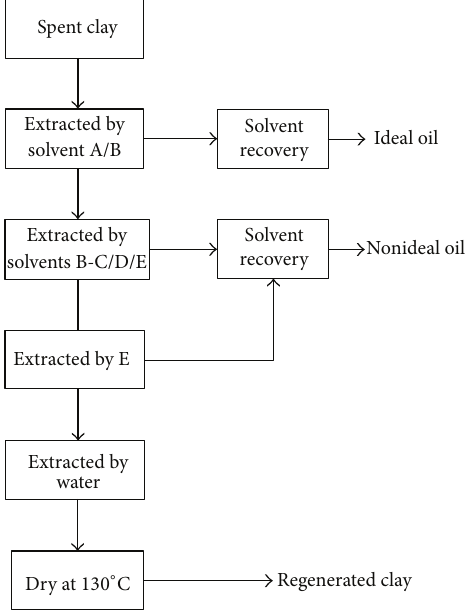
Regenerated clay Scheme 1: Regeneration